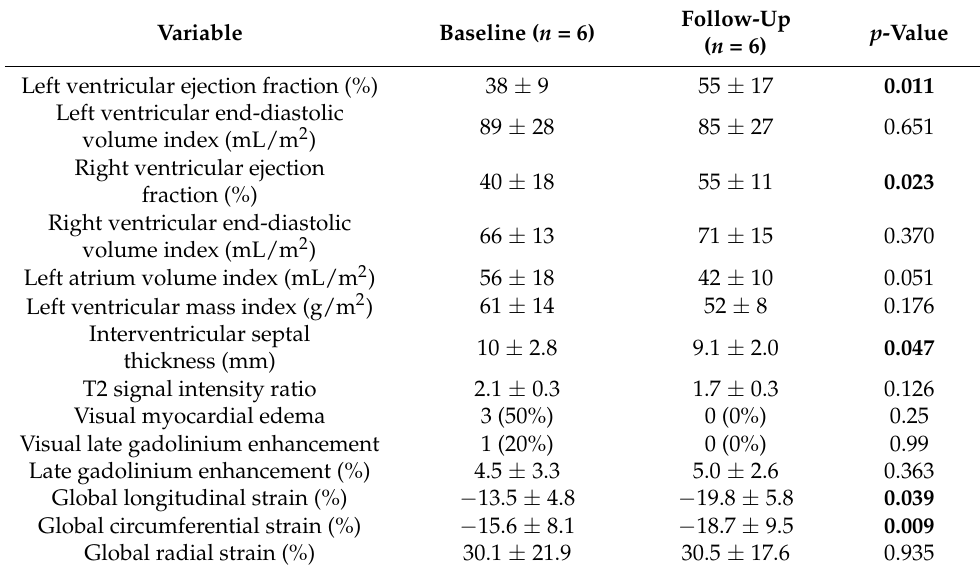
Table 2. Cardiac magnetic resonance imaging characteristics of patients with acute peripartum cardiomyopathy at baseline and